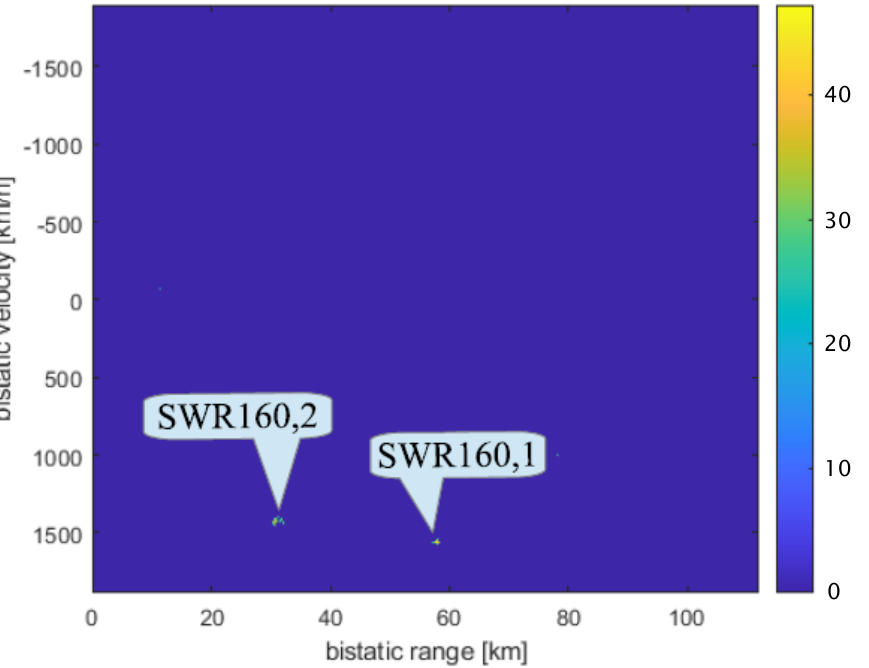
Figure 21. Cross-ambiguity function for the beam steered in the direction of the SWR160 plane. The exact value of the desirable direction was φ st = 7.95 ◦ , θ st = 19.75 ◦ . More powerful echoes of DAB+ signals reflected from the SWR160 plane can be seen in Figure 21. In the context of the SNR, the SWR 160’s echo from Srem increased by over 13 dB, and the SWR 160’s echo from Piatkowo increased by over 11.5 dB in comparison to the echoes registered by one tile. The results of the measurements of the bistatic parameters (range ˆ R ˆ V bis and velocity bis ) of the SWR160 plane are presented in Table 1. For comparison,